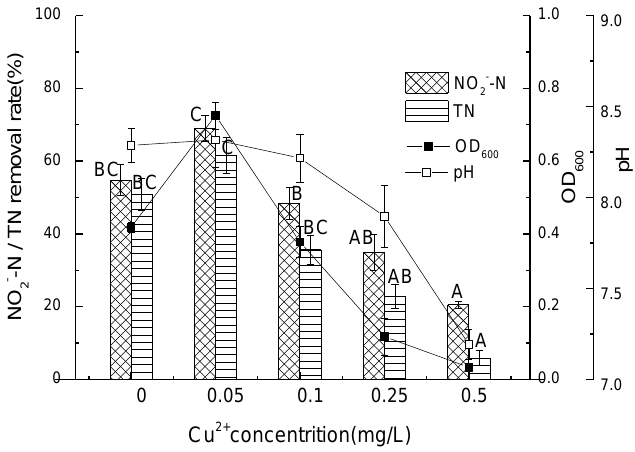
Figure 5. Effects of Cu 2+ on nitrite nitrogen removal performance of strain D51.